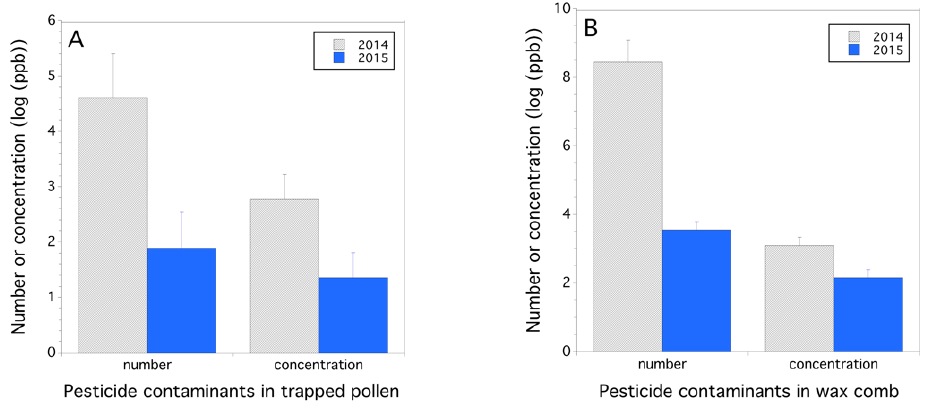
Figure 3. Concentration of pesticides and metabolites and number of pesticides detected per hive location in 2014 and 2015 in trapped pollen ( A ) and wax comb ( B ); concentration (ppb) is logarithm base 10 transformed.